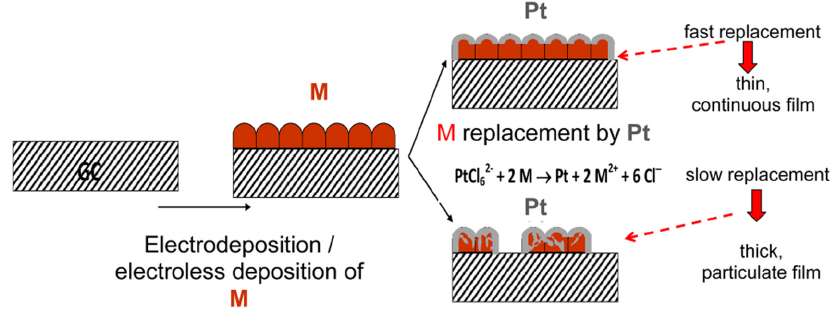
Figure 2. Schematic representation of the morphology of “platinized” M deposits, Pt(M), prepared by the galvanic replacement of continuous M layers deposited on smooth glassy carbon, GC, substrate: Continuous Pt(M) layer for fast replacement rates (top part); Particulate Pt(M) deposit for slow replacement rates (bottom part).